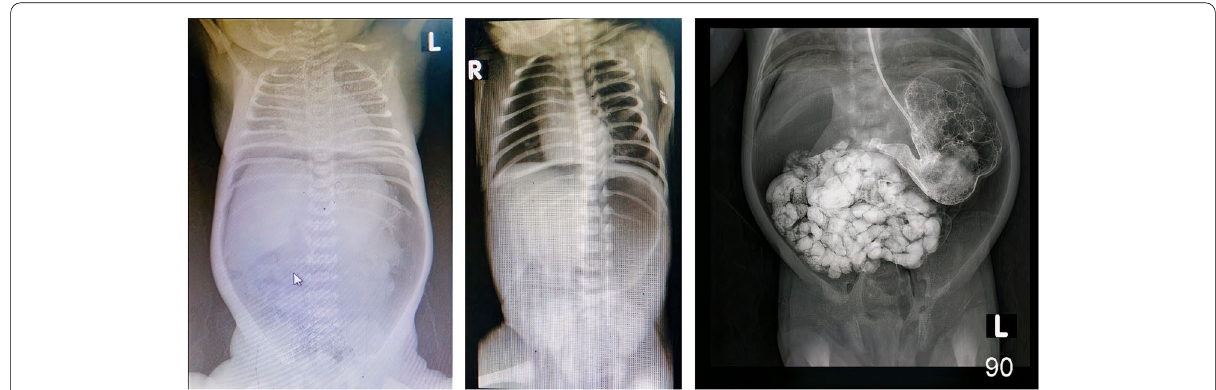
Fig. 1 a Abdominal X‑ray; showing free abdominal air, football sign. b Abdominal X‑ray follow‑up for patient in a ; showing persistent pneumoperitoneum and gastric distension. c Gastrografin follow‑through; showing small amount contrast extravasation from the